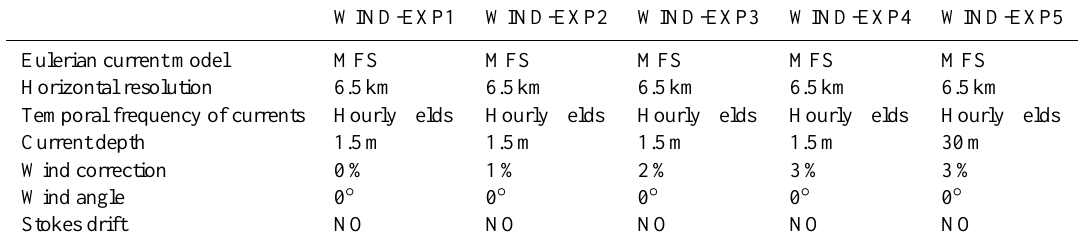
Table 2. Table of experiments designed to study the model trajectory’s sensitivity to current depth and to local wind correction.